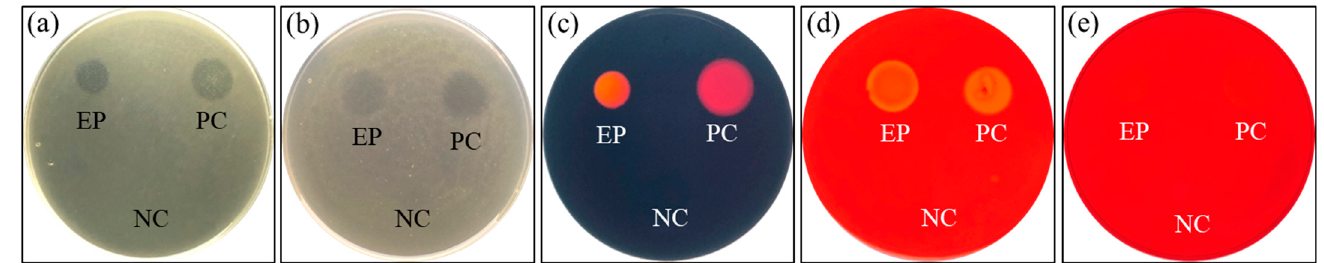
Figure 1. Analysis of the hydrolytic enzyme activities of P. ehimensis NPUST1 with a selective agar plate after cultivation for 24 h. ( a ) Protease activity; ( b ) lipase activity; ( c ) amylase activity; ( d ) cellulase activity and ( e ) xylanase activity. P. ehimensis NPUST1 was used as the experimental group (EP); Escherichia coli DH5 α was used as the negative control (NC); Bacillus amyloliquefaciens R8 was used as the positive control (PC).